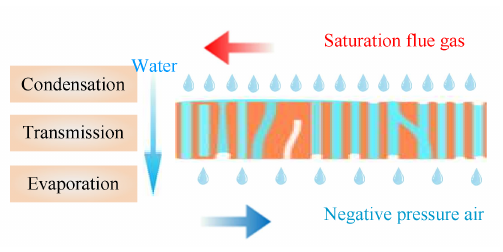
Figure 8. The water in flue gas transport